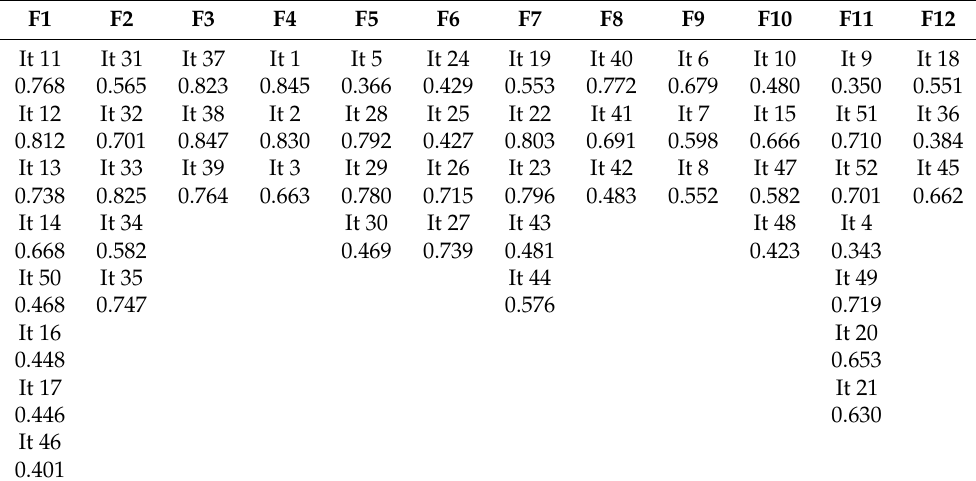
Table 2. First-order exploratory factor analysis.